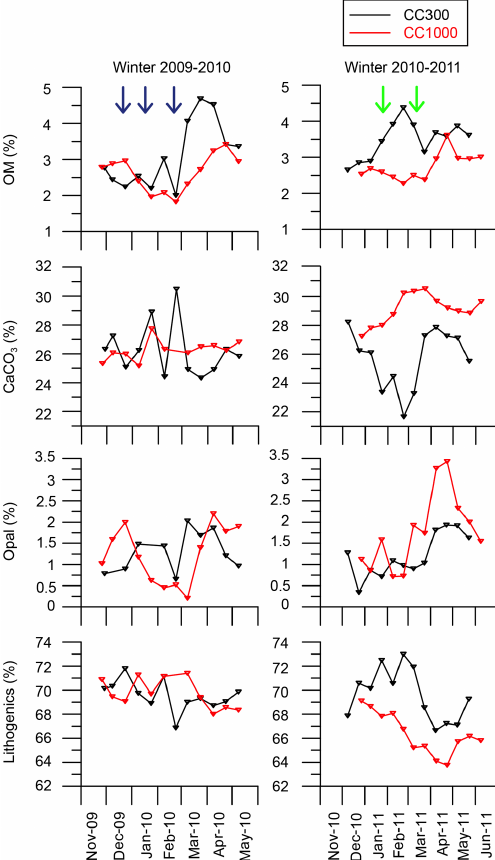
Fig. 5. Temporal variability of the main components of the settling particles (CaCO 3 , Organic Mater (OM), opal and siliciclastics) of the two stations during the two winter-spring periods studied. Black line represents the CC300 station whereas the red line represents the CC1000. (a) Winter-spring 2009–2010. (b) Winter-spring 2010– 2011. Blue arrows show periods of intense heat losses and DSWC event (as in Figs. 2 and 3), and green arrows show eastern storms events (as in Fig.